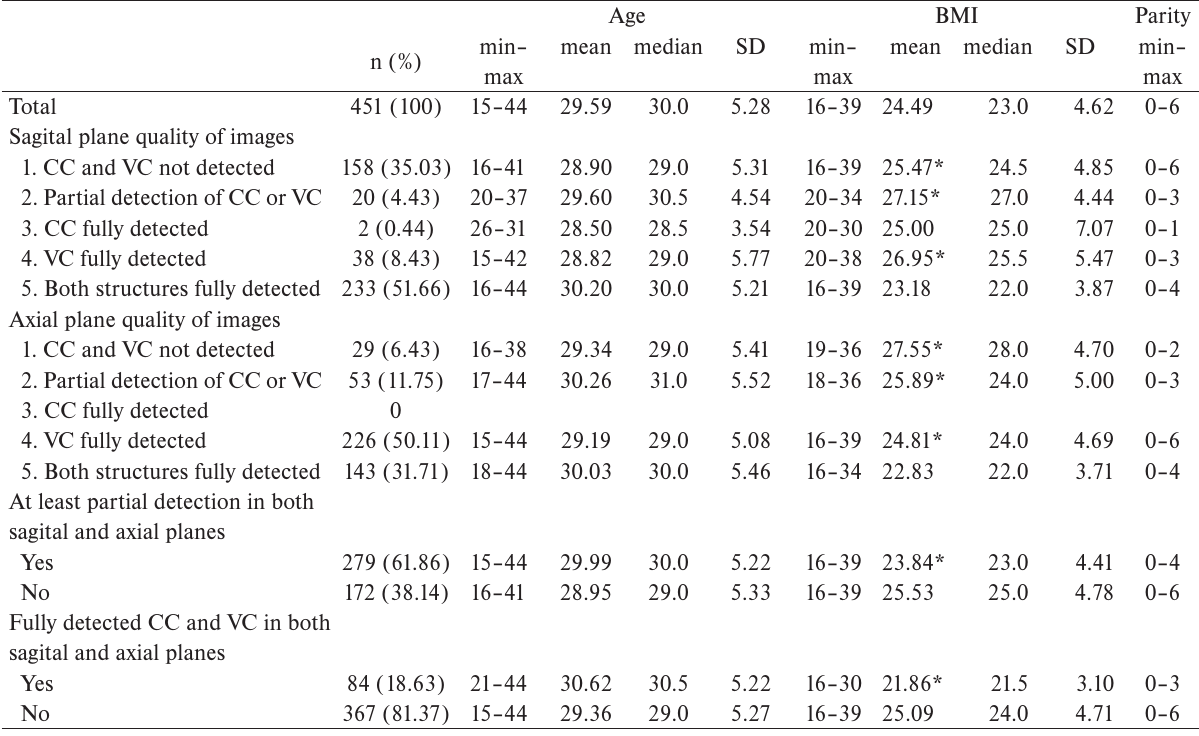
Table 1. Descriptive characteristics of the sample and nonparametric comparison of medians between groups (Wilcoxon rank-sum and Kruskal-Wallis tests with Bonferroni correction for multiple comparison).